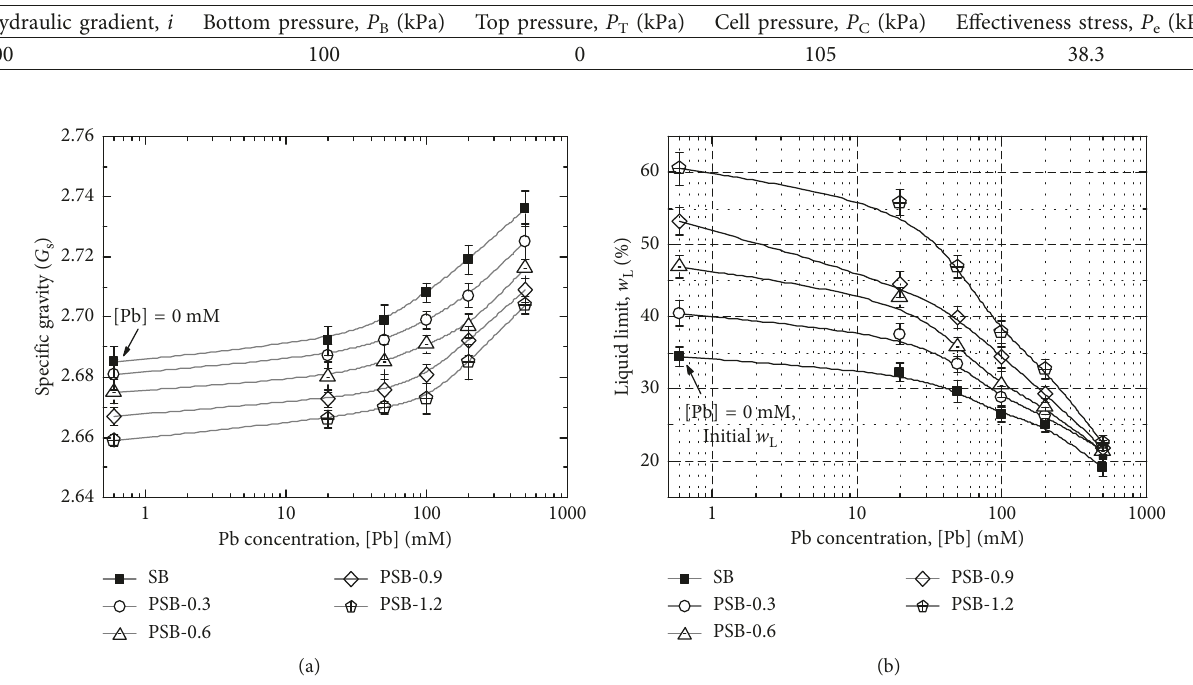
Figure 3: (a) The relationship between specific gravity of backfills and Pb concentrations (number of replicates 0.01) and (b) the relationship between liquid limits of backfills and Pb concentrations (number of replicates